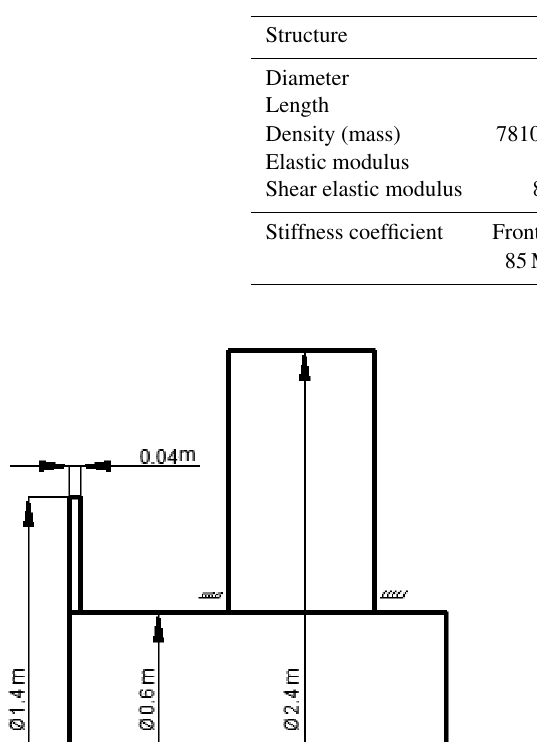
Table 1. Details of the motorized spindle-tool system for the numerical example.